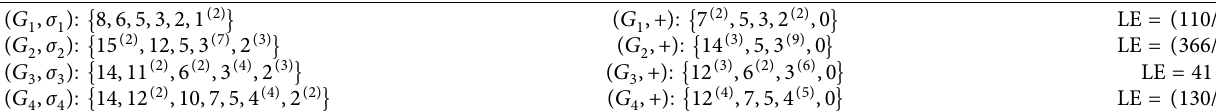
Figure 1: Examples in theorems. Table 1 The Laplacian spectra in